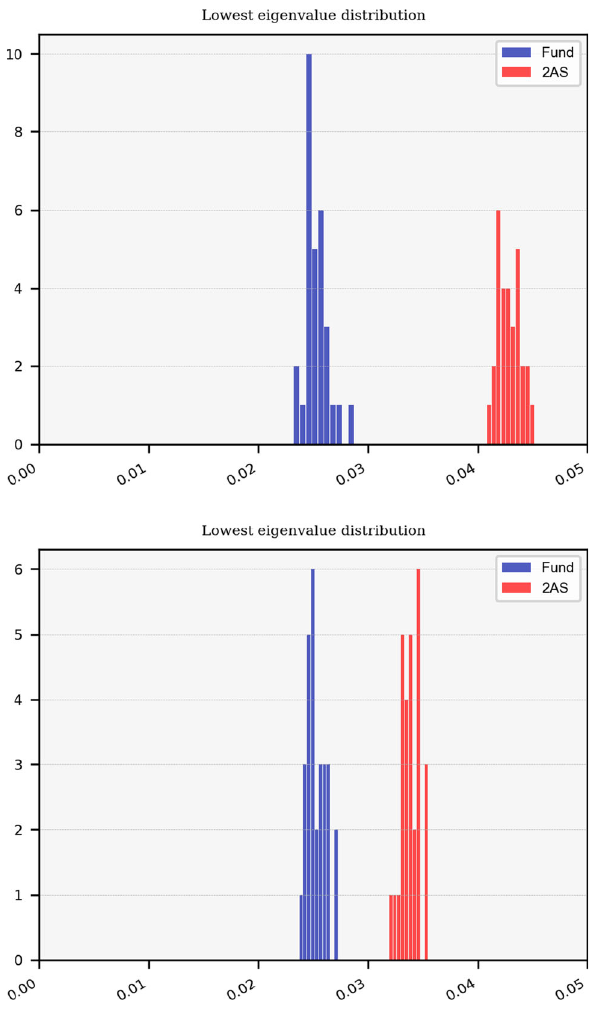
Fig. 3 DistributionofthelowesteigenvalueoftheWilson-cloveroper- ( Fund ) = − 0 . 45 , β = 11 and differ- ator for bare parameters am 0 ( 2AS ) = − 0 . 59 on the top and ent masses for the 2AS fermions: am 0 = − 0 . am ( 2AS ) 0